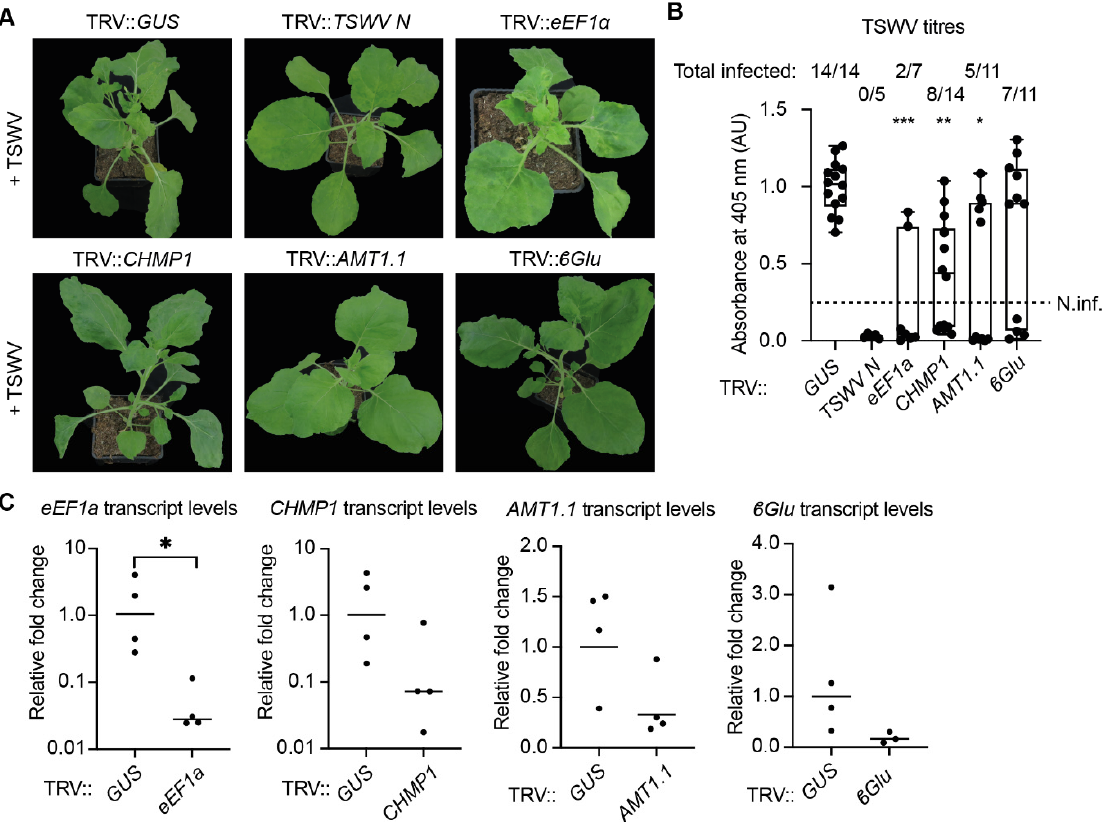
Figure 3. Knockdown of the genes eEF1A , CHMP1 , AMT1.1 , and β Glu results in reduced TSWV titres in N. benthamiana . ( A ) Growth phenotypes of N. benthamiana plants silenced for eEF1A , CHMP1 , AMT1.1 , or B-Glu . Four-week-old silenced plants were rub-inoculated with TSWV, and pictures were taken two weeks later. ( B ) TSWV titres determined by DAS-ELISA of the TSWV-inoculated plants shown in ( A ); viral titres were normalised to negative control (TRV:: GUS ). Plants were considered to be non-infected when the viral titres were below 0.25 arbitrary units (AU), and the number of infected plants is indicated above the bars. Kruskal–Wallis test with a Dunn’s post hoc test was performed (*, p -value < 0.05; **, p -value < 0.01; ***, p -value < 0.001). ( C ) Transcript levels of eEF1A , CHMP1 , AMT1.1 , and β Glu of the silenced plants shown in ( A ). Transcript levels were compared to the control plants (TRV:: GUS ) (n = 4). Unpaired Student’s t -test (*, p -value < 0.05).